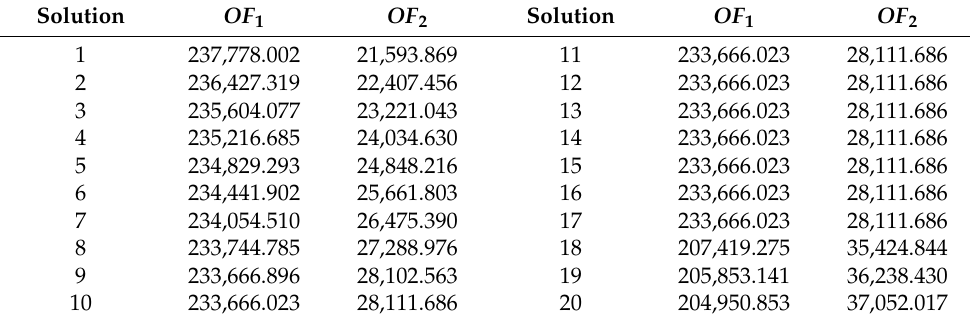
Table 12. Objective function values for the small-sized test problem.